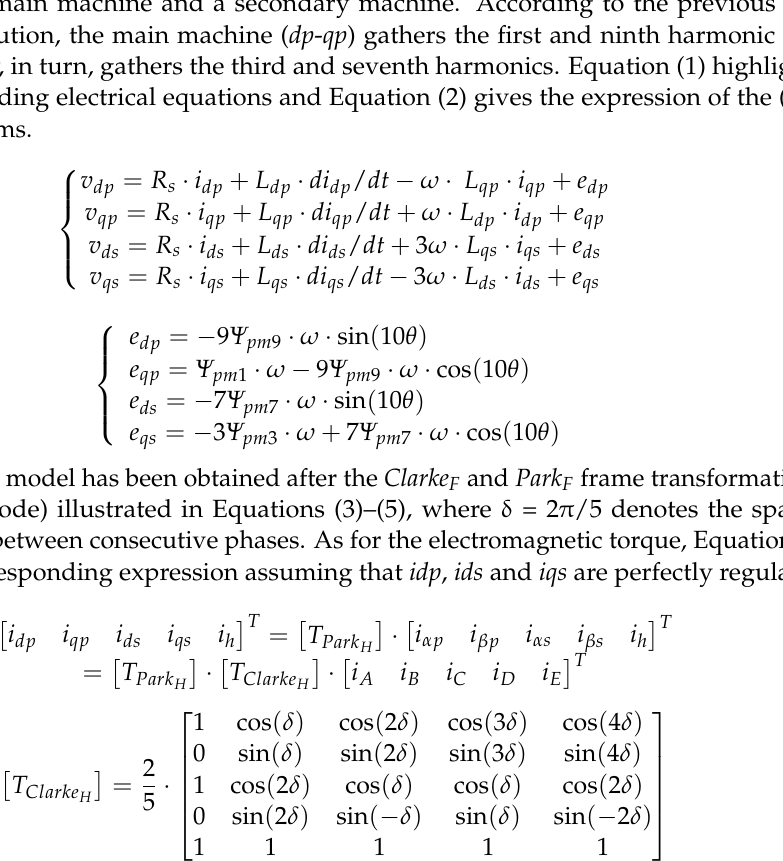
Figure 4. Measured Back-EMF waveform ( a ) and harmonic distribution ( b ).